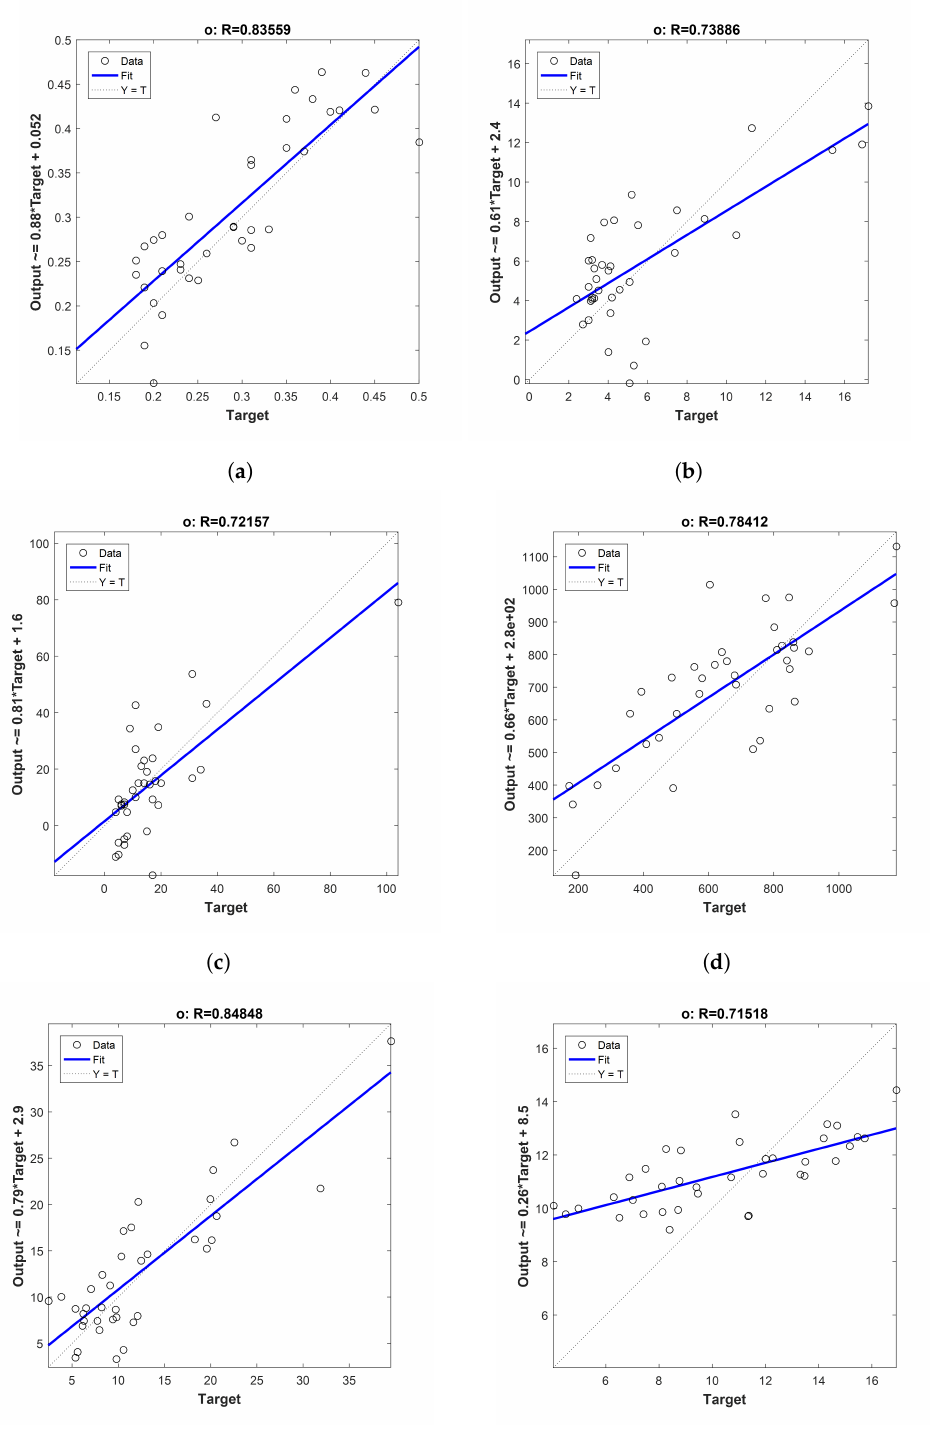
Figure 5. Fruit Image correlations by PLS are presented for different oil parameters. ( a ) Acidity Index. ( b ) Peroxide Index. ( c ) Ethyl Ester. ( d ) Polyphenols. ( e ) Chlorophylls. ( f )